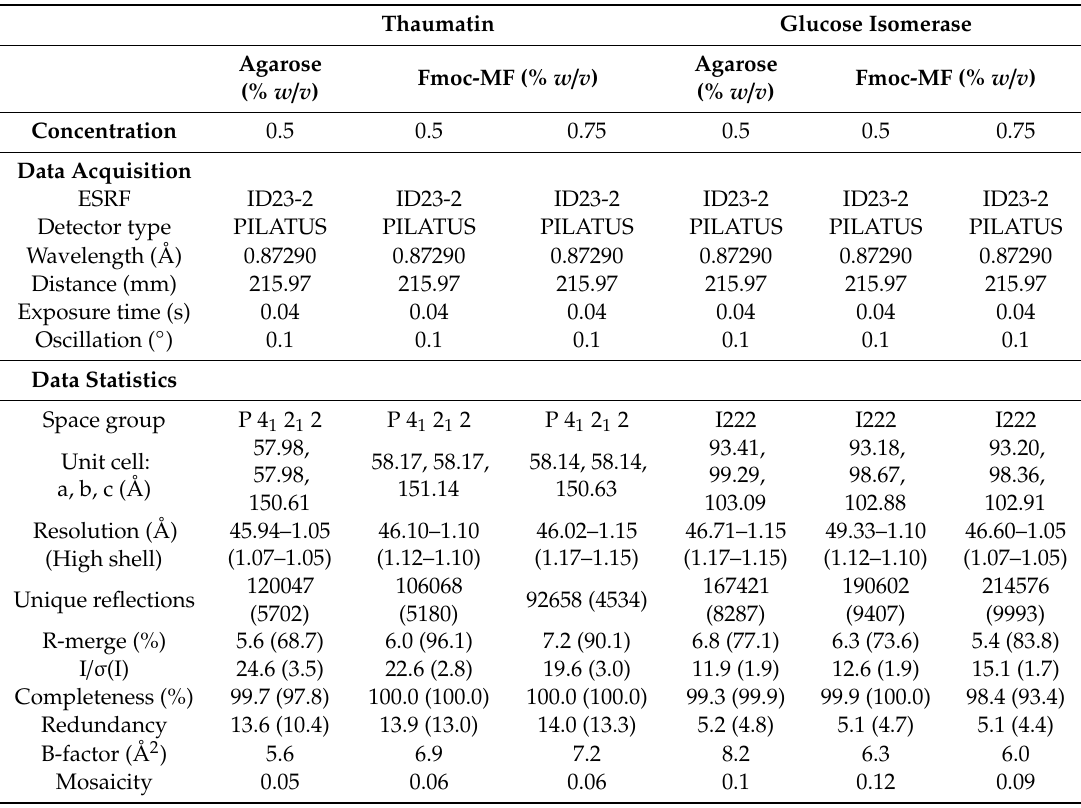
Table 3. Summarized the data collection conditions and final statistical values of thaumatin and glucose isomerase crystals obtained in Fmoc-MF and in agarose hydrogels (data in brackets correspond to the high-resolution